Question: Author a descriptive caption for the visualization shown.
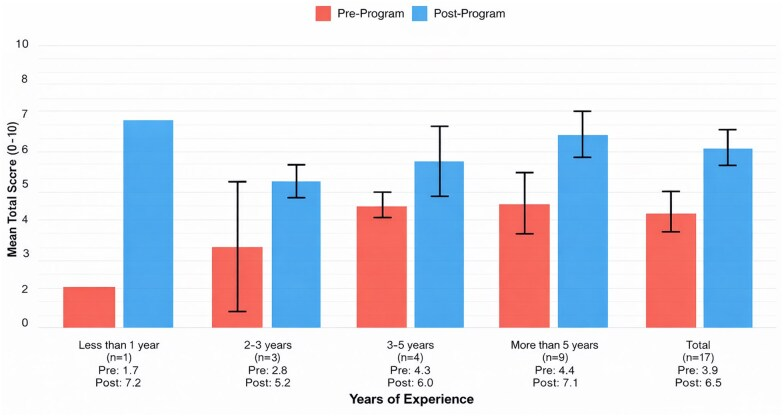
Answer: Comparison of pre vs post-training score across years of experience. Pre- and post-training assessment scores stratified by participants’ years of professional experience, demonstrating changes in performance following the training intervention.